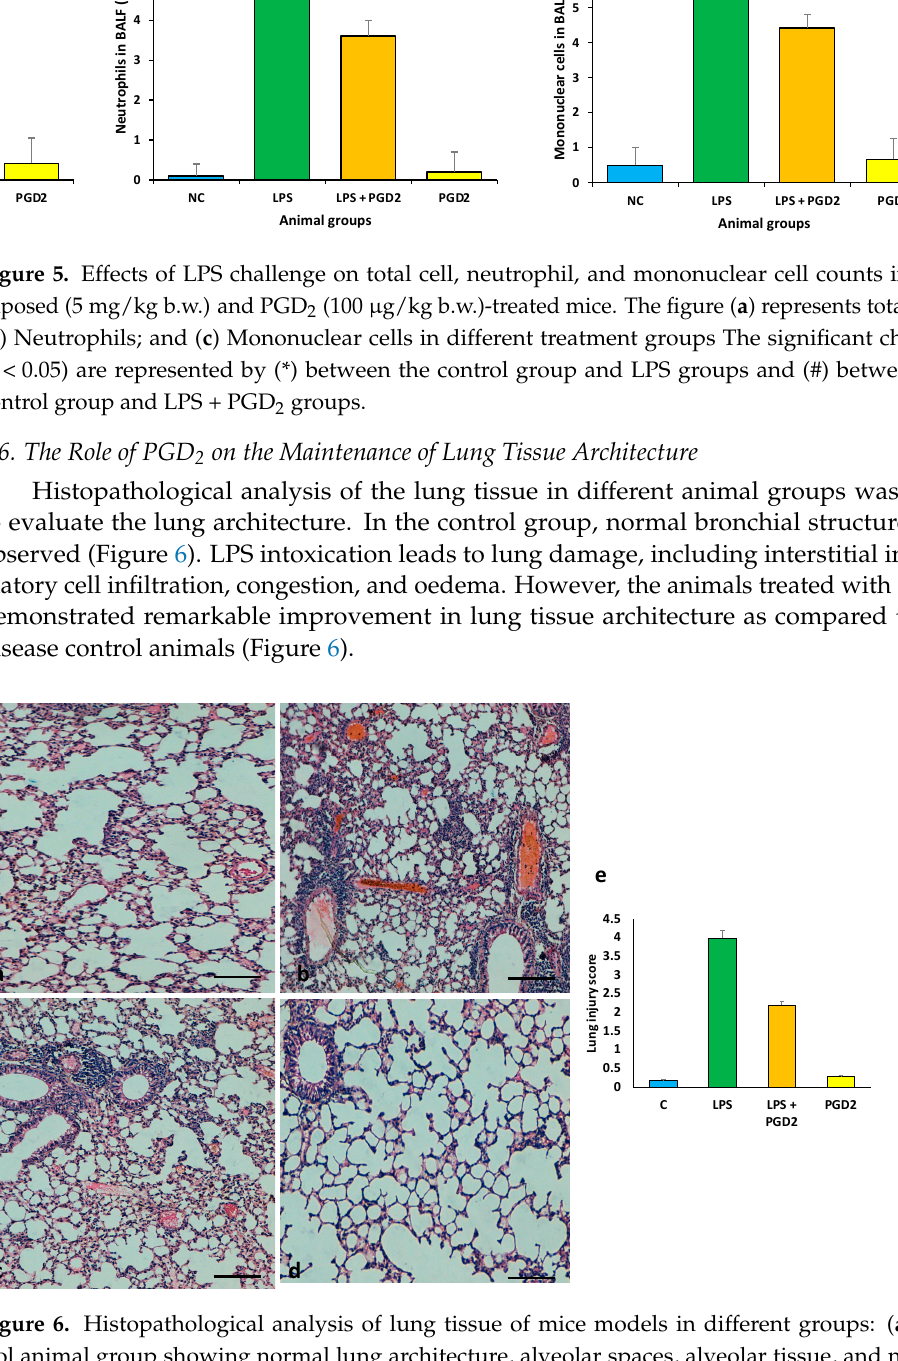
8 of 15 Figure 4. Proinflammatory marker levels in various groups of mice. The values represent the mean ± SEM, with 8 mice in each group. Treatment with LPS (5 mg/kg b.w.) (Group 2) enhanced IL - 1 β , IL-6, CRP, and TNF- α levels in comparison to NC animals. Management with PGD 2 (100 μ g/kg b.w.) remarkably reduced the levels of these parameters in Group 3 (LPS + PGD 2 ) animals ( p < 0.05). The figure ( a ) represents IL-1 β ; ( b ) IL-6; and ( c ) CRP and ( d ) TNF- α in different treatment groups. Sta- tistically significant differences ( p < 0.05) are represented by (*) between the NC and LPS groups and (#) between the NC and LPS + PGD 2 groups. 3.5. Effect of PGD 2 on Inflammatory Cells Influx in BALF The number of inflammatory cells, such as neutrophils and mononuclear cells (mac- rophages and monocytes), was calculated in BALF, and it increased significantly after the LPS (5 mg/kg b.w.) challenge as compared to the control sample ( p < 0.05). The number of neutrophils and mononuclear cells in the PGD 2 (100 μ g/kg b.w.) treatment group, prior to LPS insult, was remarkably reduced overall (Figure 5). LPS exposure remarkably en-